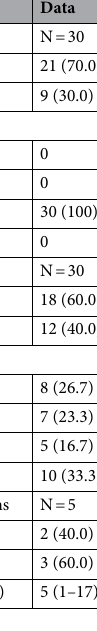
Table 1. Demographics of students, residents and certified pediatric